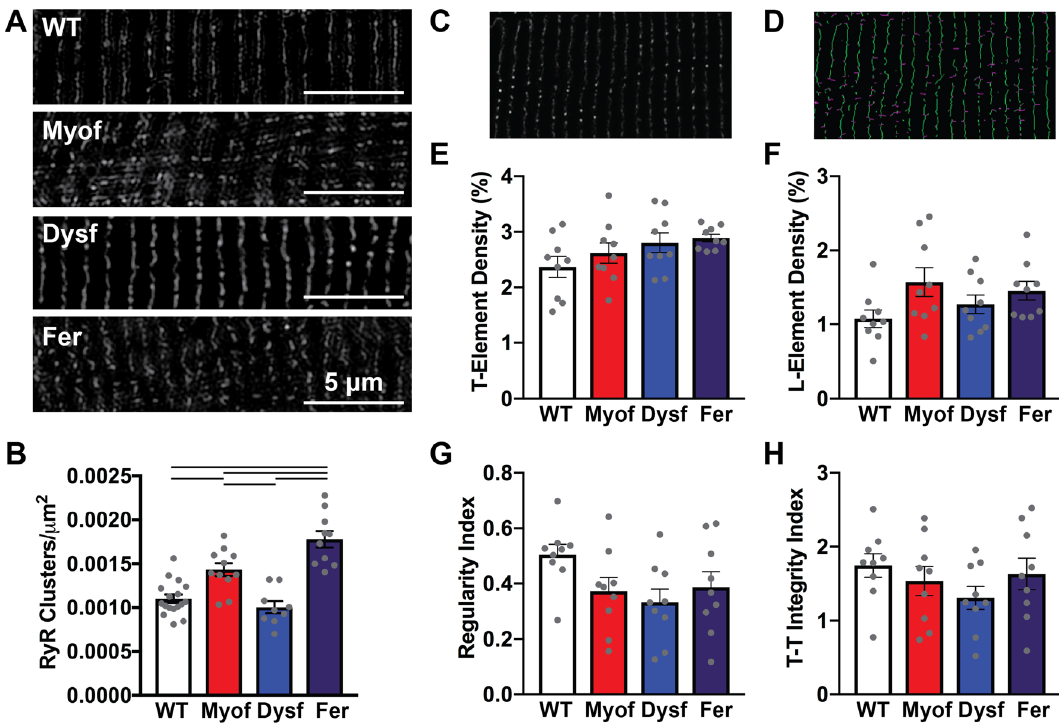
Figure 5. Loss of myoferlin resulted in reduced RyR cluster regularity and improper localization. ( A ) Representative SIM images of anti-RyR FDB myofiber staining in all genotypes. ( B ) RyR cluster counts per area are significantly higher in Myo and Fer myofibers than WT and Dysf (N = WT 3 mice, 17 fibers; Myof 3 mice, 11 fibers; Dysf 3 mice, 9 fibers; Fer 3 mice, 10 fibers). ( C , D ) Representative SIM image of RyR staining in isolated FDB myofibers and a corresponding thresholded, skeletonized image used for Auto-TT analysis of RyR cluster organization. ( E ) Transverse (t) RyR clusters were not significantly changed between genotypes. ( F ) There were spacing shows non-significant reduction in Myof and Fer compared to WT and Dysf myofibers. N = 3 mice, 3 fibers per